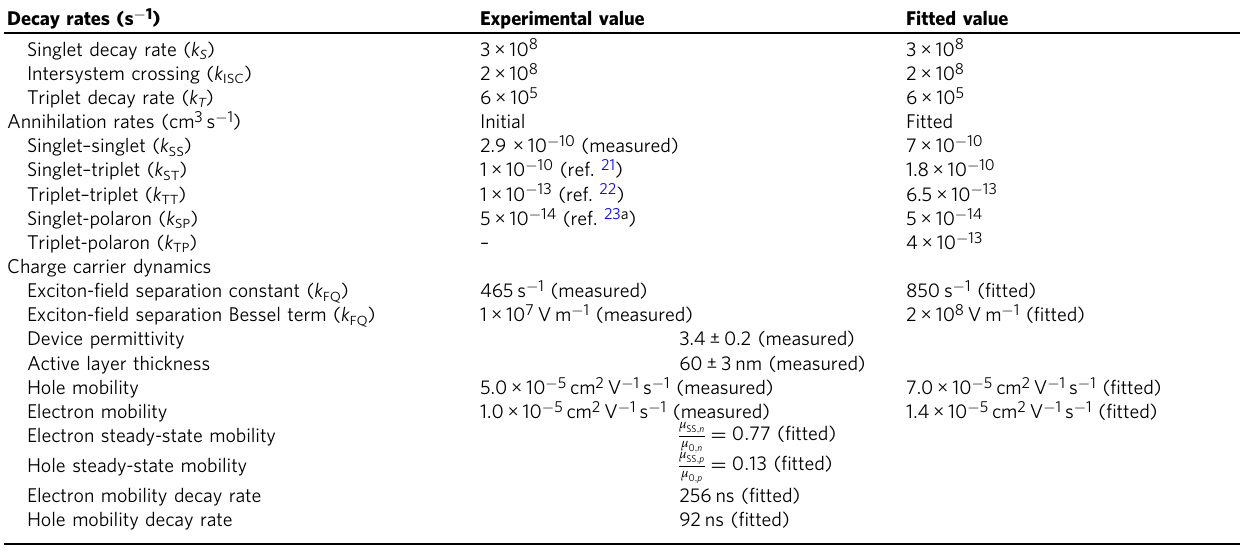
Table 1 Decay and annihilation rates.